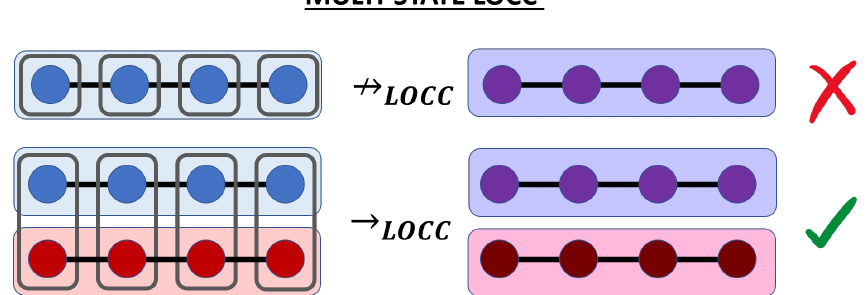
Figure 1: Illustration of an LOCC transformation between the states | ψ 〉 and | φ 〉 that is not possible in the single-state regime, but that becomes possible in the multi-state regime, by adding the auxiliary state, | ¯ ψ 〉 . Locality is now defined to include parts of both states. Note that transformations of the target state under LOCC are clearly a subset of transformations of the target state under multi-state